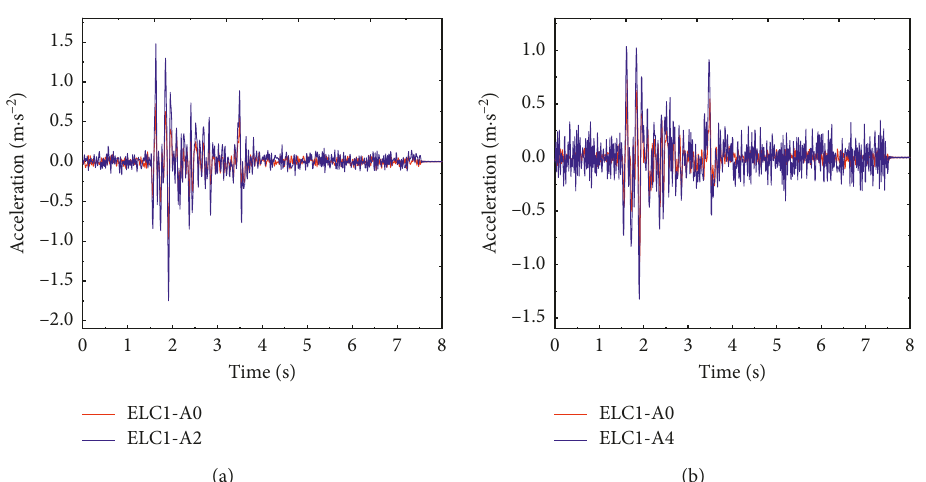
Figure 8: (a) Comparison of acceleration time-history curves between A2 and A0. (b) Comparison of acceleration time-history curves between A4 and